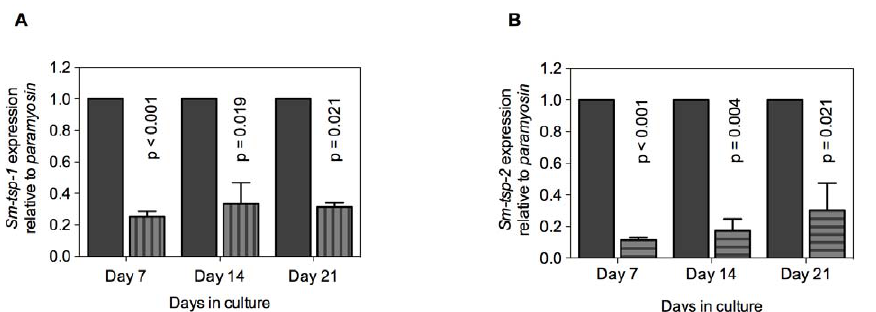
Figure 4. Suppression of Sm-tsp mRNAs in schistosomula by RNAi. Sm-tsp-1 (A) and Sm-tsp-2 (B) transcript levels relative to Sm-paramyosin (mean 6 S.E.) in schistosomula soaked for 7, 14 and 21 days with 1 m g/ml of Sm-tsp or luciferase control dsRNAs.